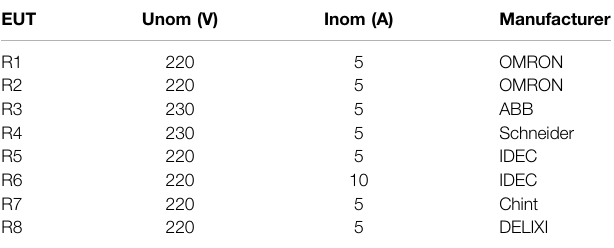
TABLE 1 | The main parameters of